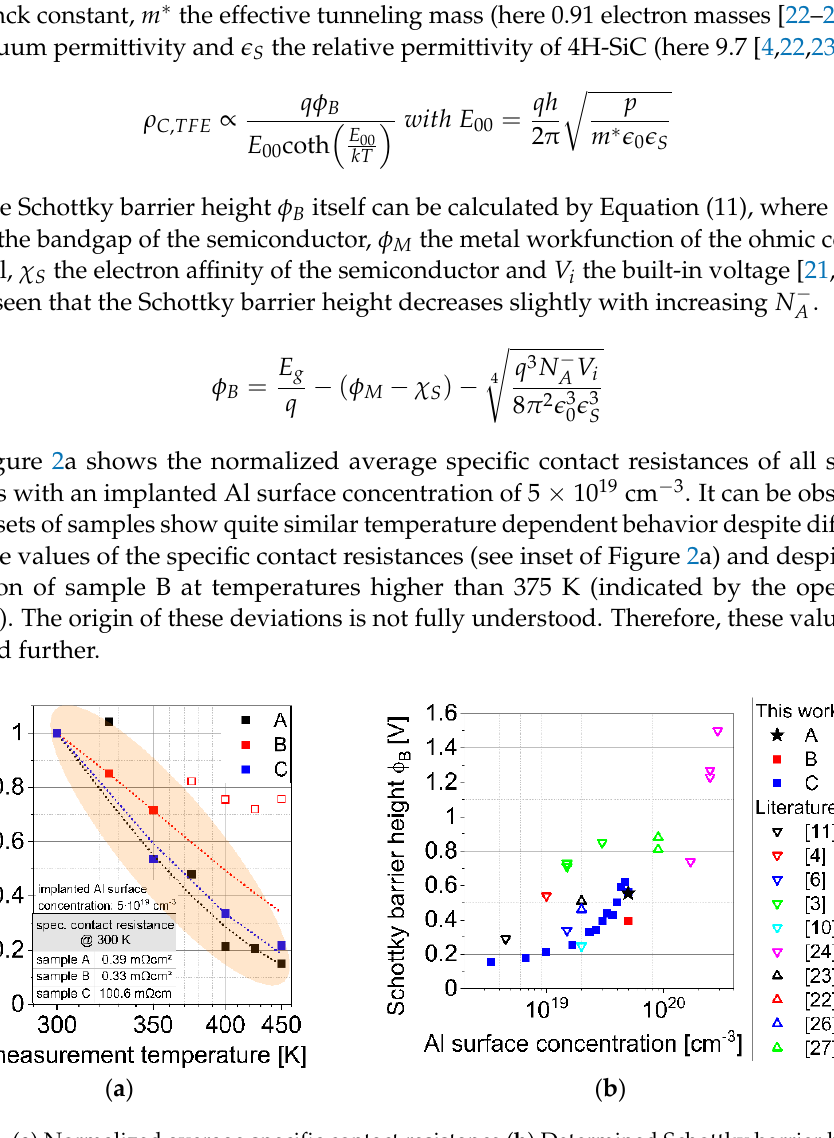
Figure 2. ( a ) Normalized average specific contact resistance ( b ) Determined Schottky barrier heights form this work and literature. Ohmic contacts from literature fabricated on epitaxial regions are indicated with ∇ ([3,4,6,10,11,24]), ohmic contacts from literature fabricated on implanted regions are indicated with Δ ([22,23,26,27]).